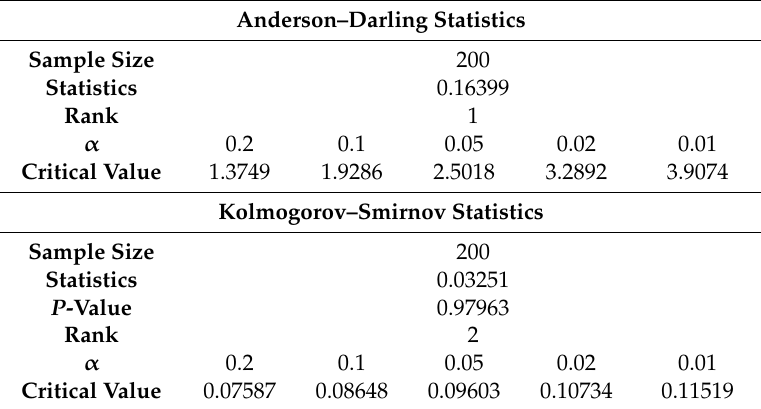
Table 5. Best-fitted PDF (Generalized Extreme Values distribution) statistical summary.